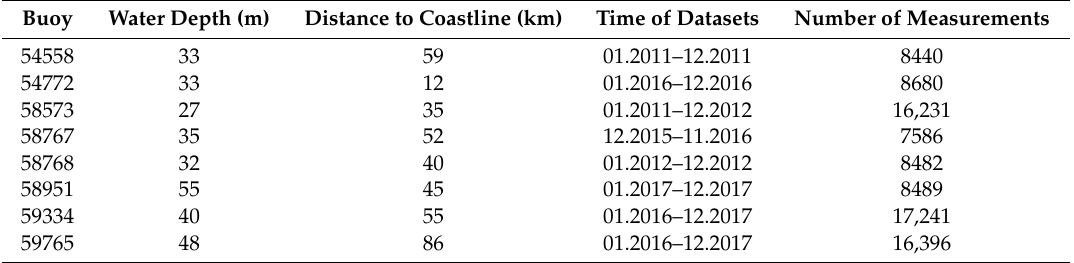
Figure 2. Geographical location of meteorological stations and buoys. Table 1. Information for buoy measurements.